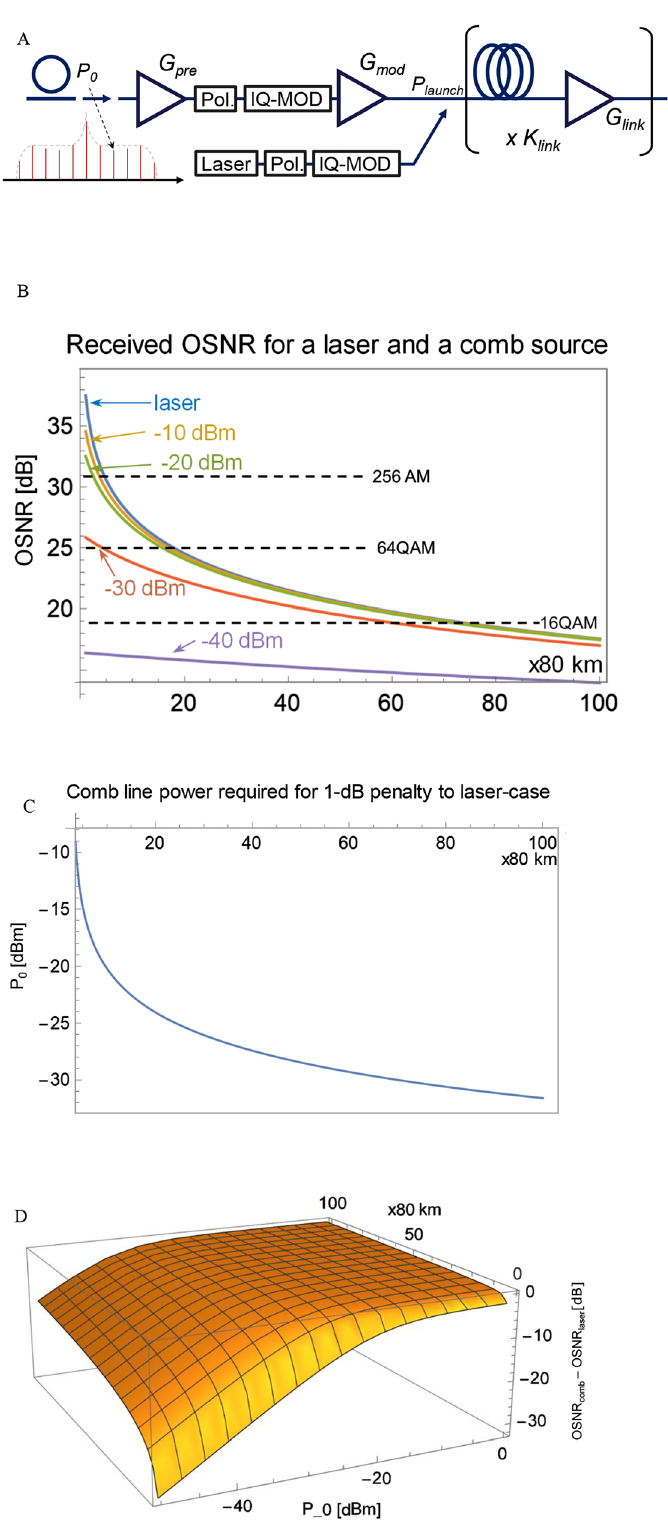
Figure 2: Investigating the power per comb line for various transmission